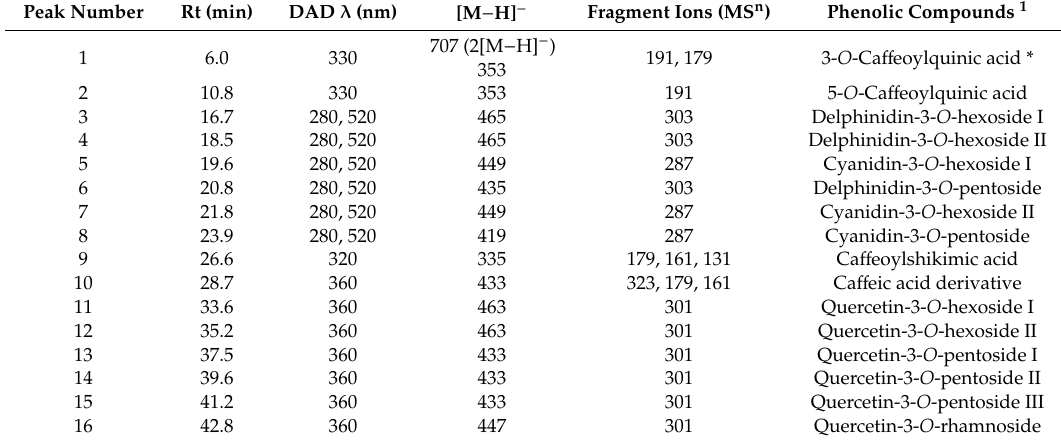
Table 2. Phenolic compounds detected and characterized tentatively in Andean blueberry samples ( n = 3) by HPLC-DAD-ESI / MS n . Compounds were numbered by their elution order.